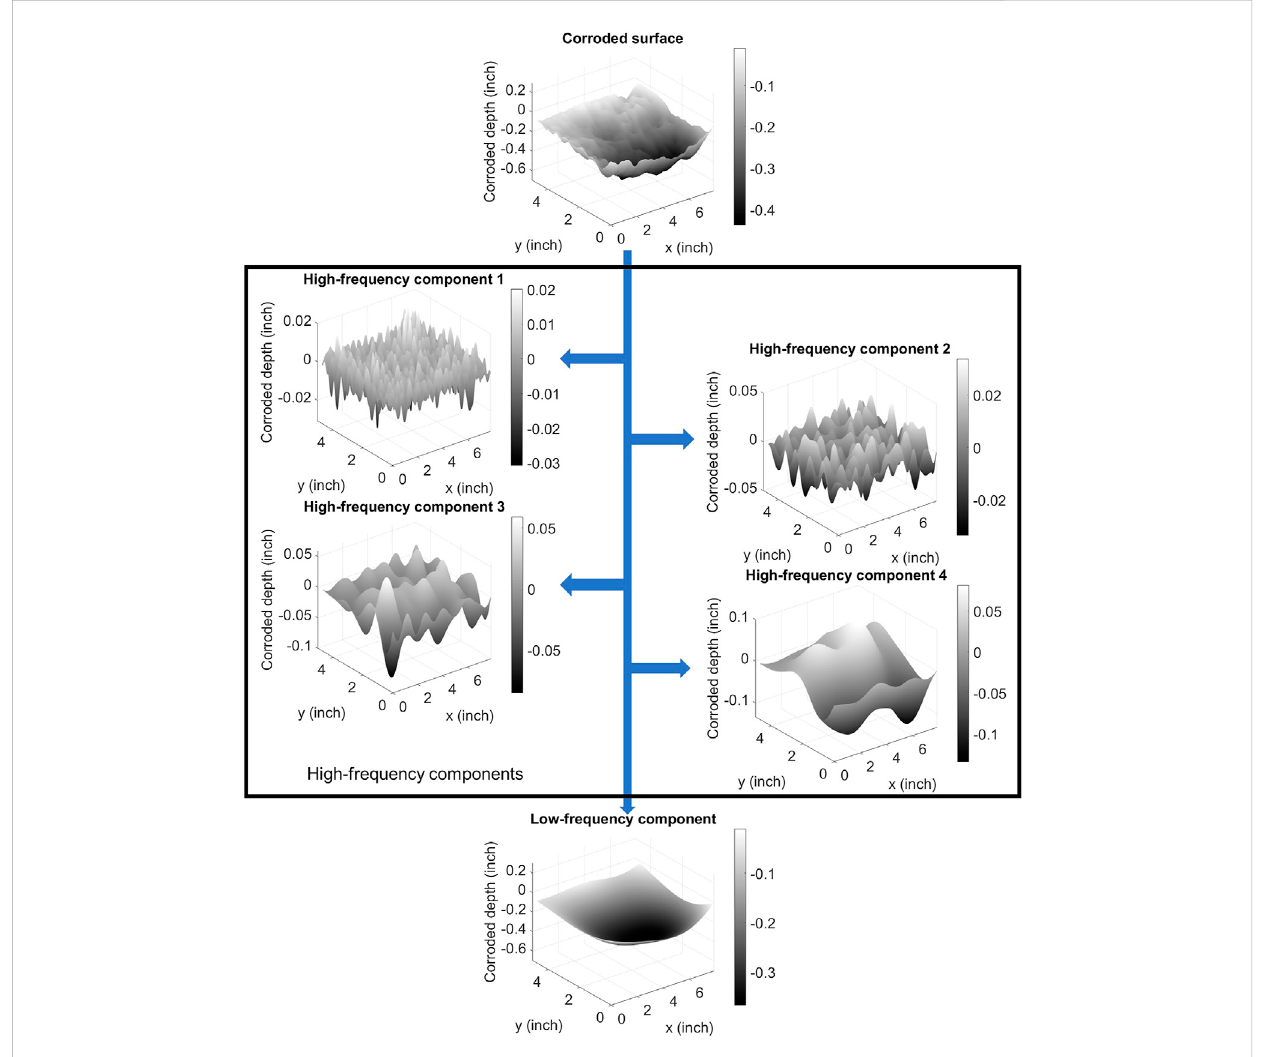
FIGURE 3 Decomposition of a corroded surface into four high-frequency components and one low-frequency component using Lanczos fi lters. The dimension of corroded depth is exaggerated in this fi gure for visualization purposes only.